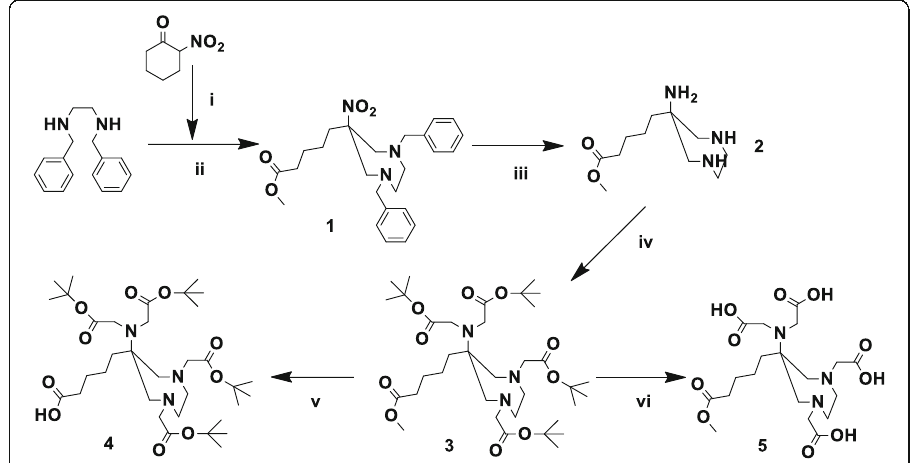
Fig. 1 Synthesis of the bifunctional chelator AAZTA 5 : (i) A21, MeOH, in situ; (ii) paraformaldehyde,